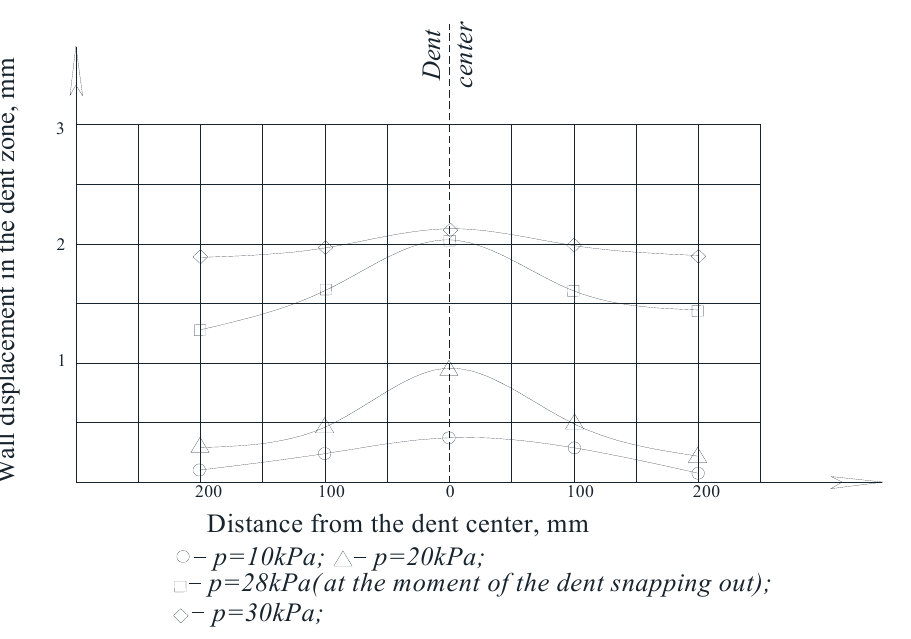
Figure 10. The wall displacements of the model, M1 ‐ A, at the characteristic spherical dent zone points [33,34].